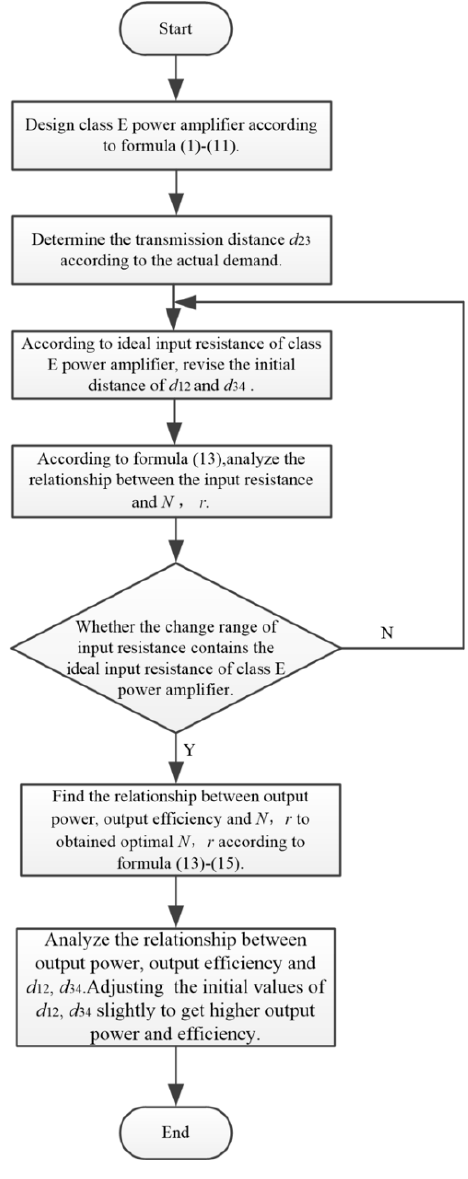
Figure 4. Flow chart of design progress.